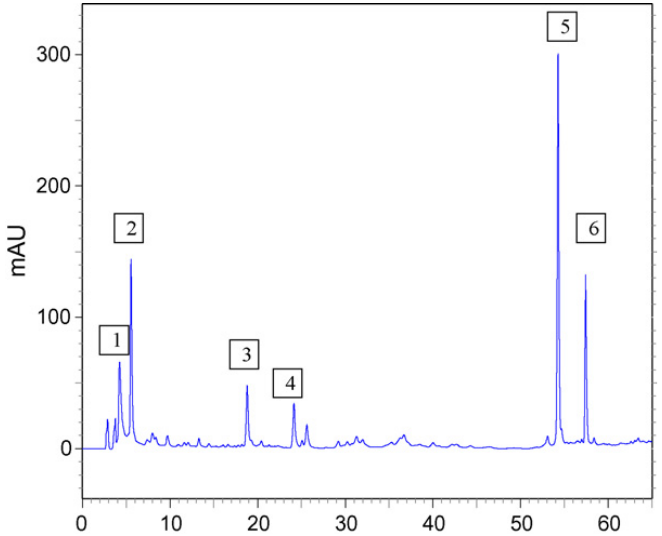
Figure 2. HPLC profile of Bd-EAE. 1 : caffeic acid; 2 : p -coumaric acid; 3 : aromadendrin- 4 ′ - O -methyl ether; 4 : 3-prenyl- p -coumaric acid (drupanin); 5 : 3,5-diprenyl p -coumaric acid (artepillin C); 6 :